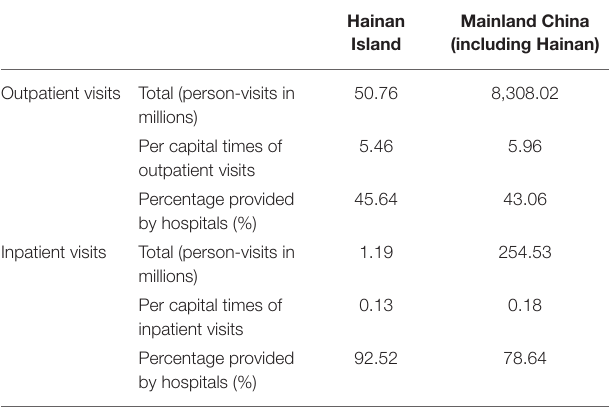
TABLE 1 | Comparison of healthcare utilization on Hainan Island and